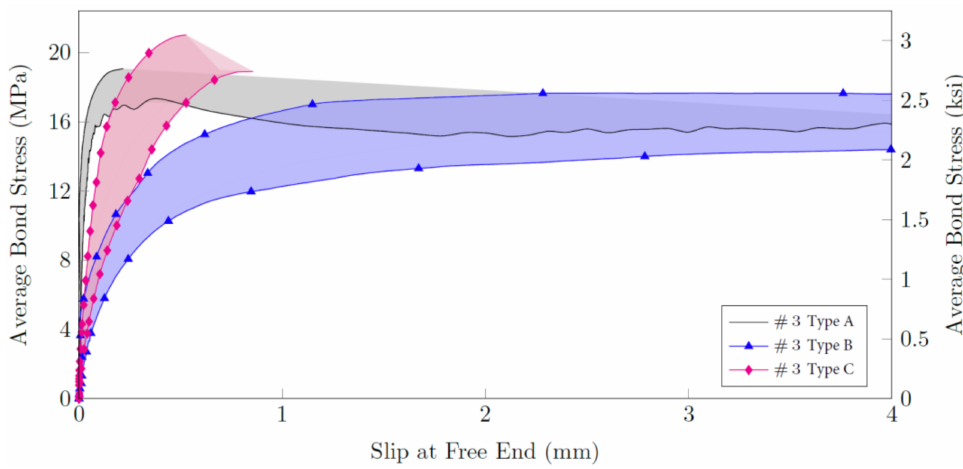
Figure 4. Bond-slip (free-end) behavior of unaged